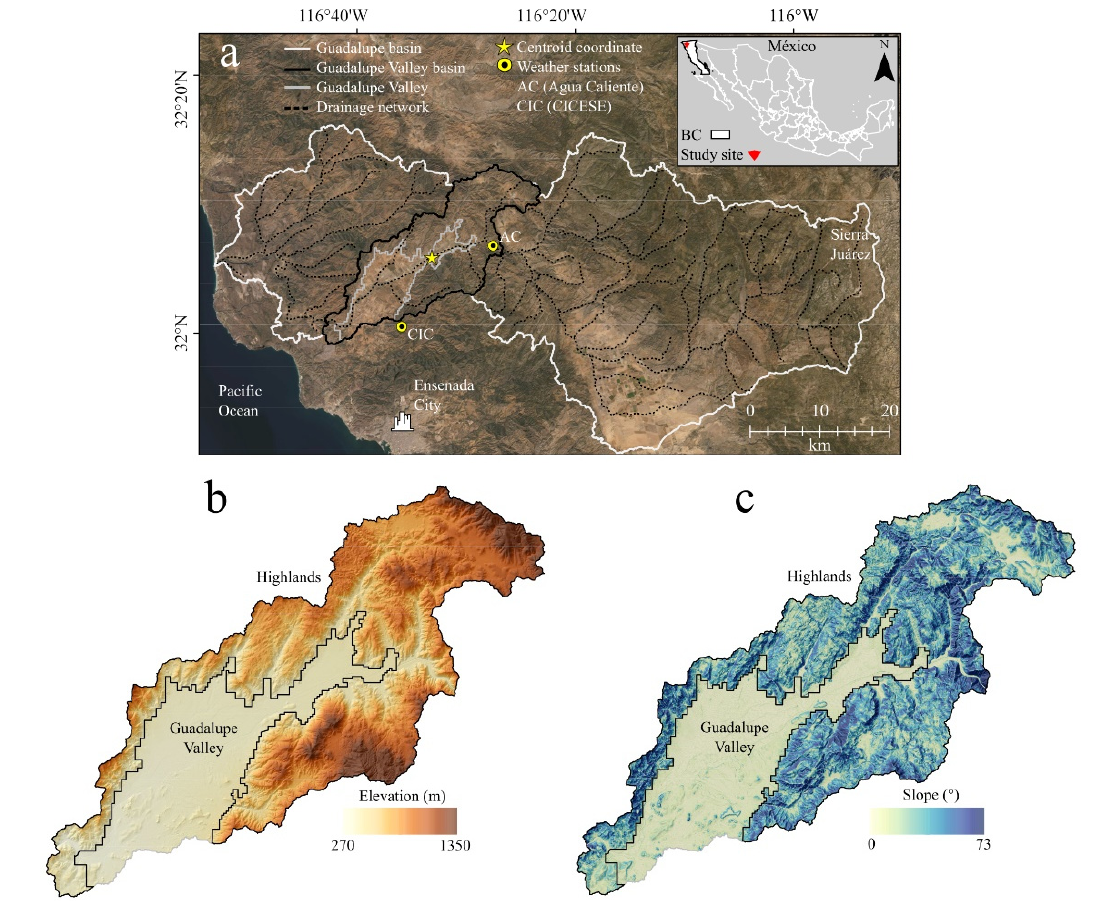
Figure 1. ( a ) Macro location of the Guadalupe Basin and the study area in Baja California, Mexico, ( b ) elevation and ( c ) slope of the study area (Guadalupe Valley Basin).